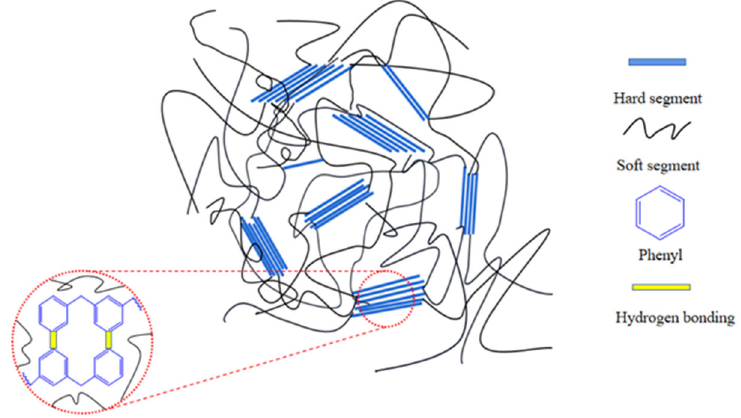
Figure 7. Polyurethane microphase separation structure.